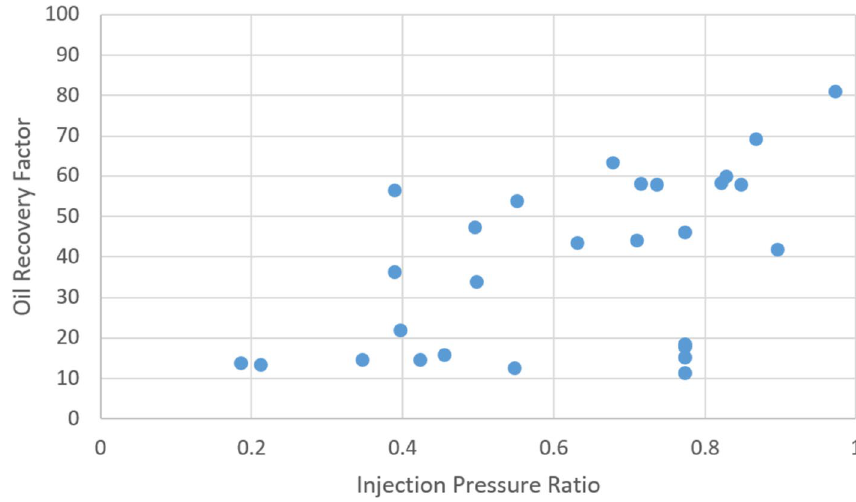
Fig. 4 Injection pressure ratio for CO 2 core-flooding